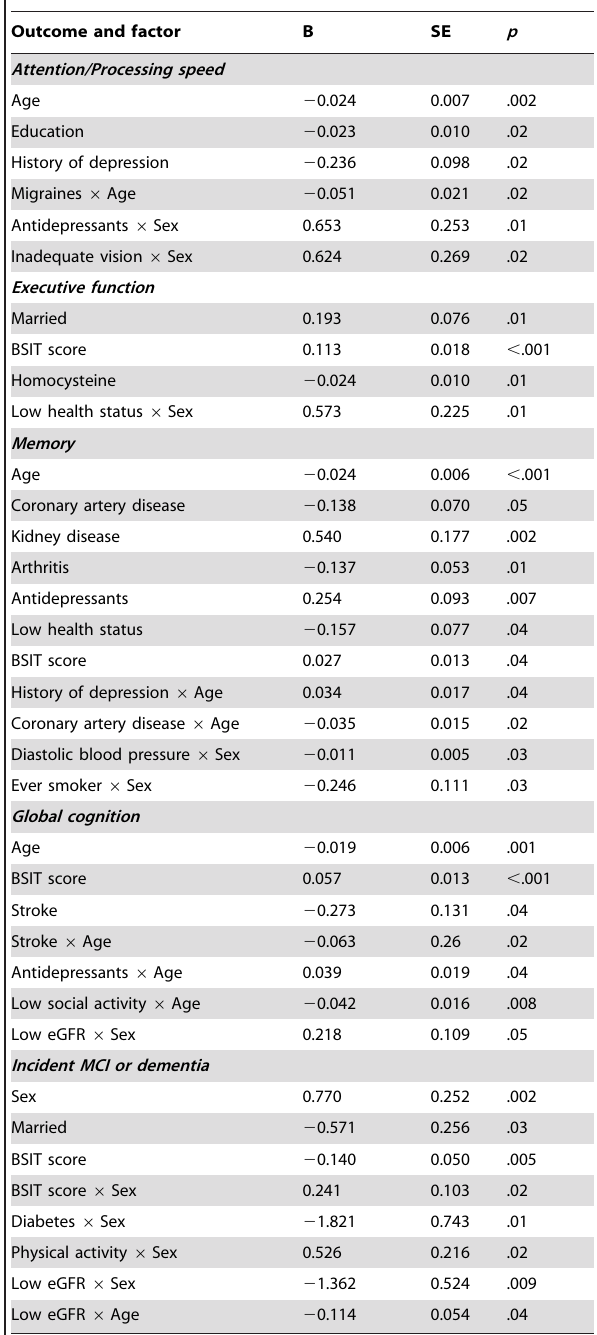
Table 3. Baseline factors associated with cognitive decline a